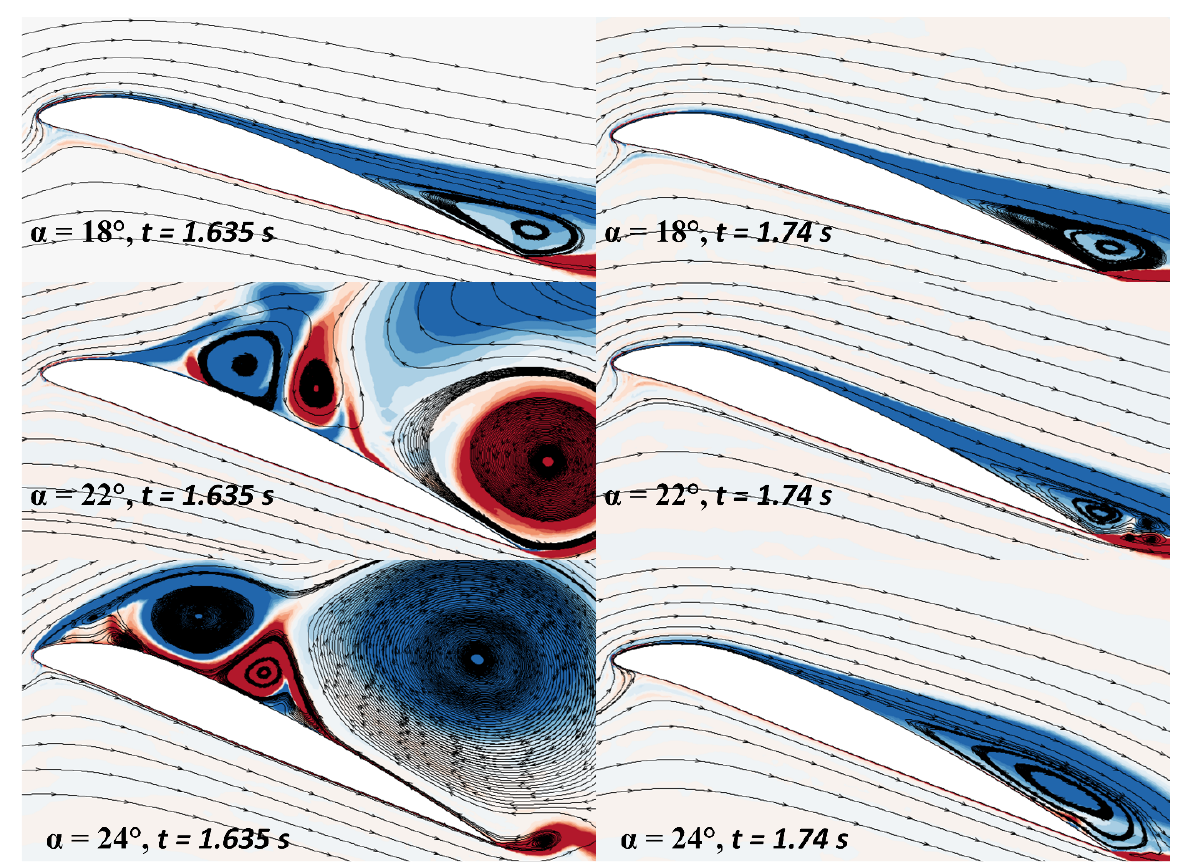
Figure 16. Vorticity contours with flow streamlines at different time steps and angles of attack (18°, 22°, and 24°).